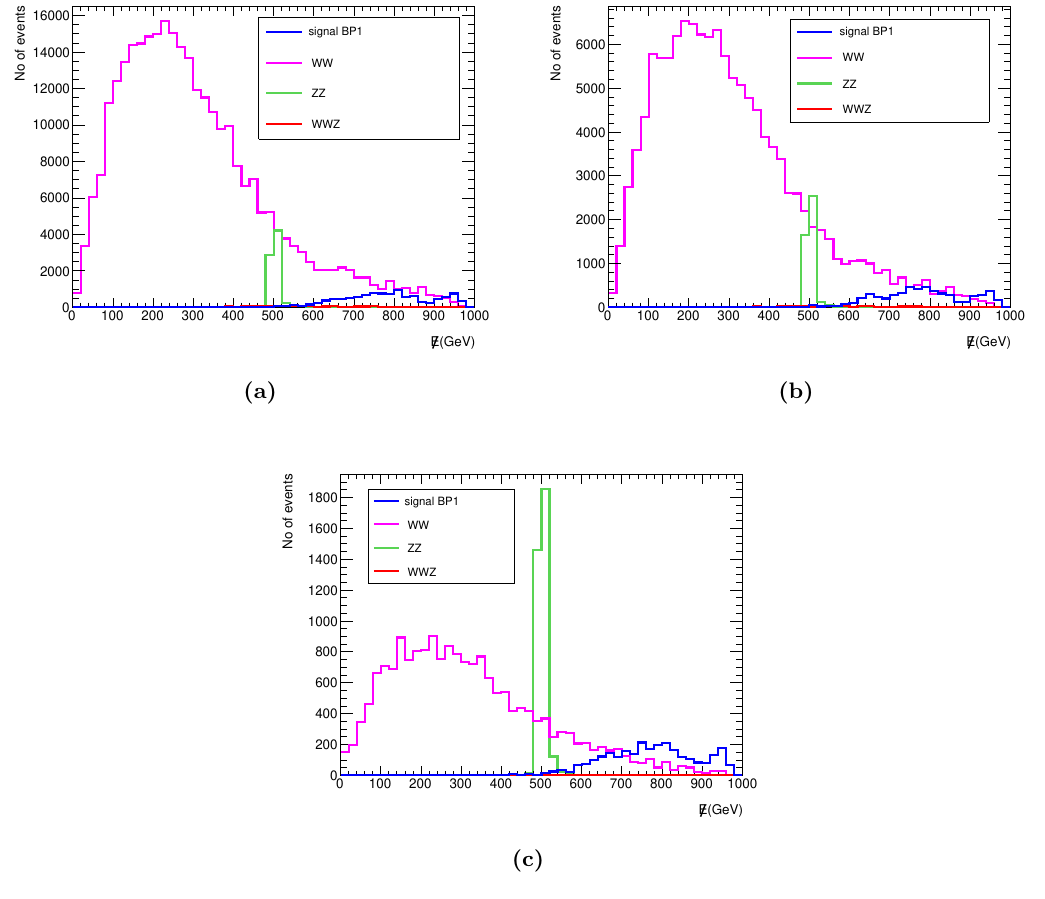
Figure 11. Unnormalized ‘ + ‘ − event distribution for /E at ILC with for BP1 along with WW and ZZ backgrounds for various degrees of beam polarisation, (a) P1, (b) P2 and (c) P3 (see caption of table 3 and